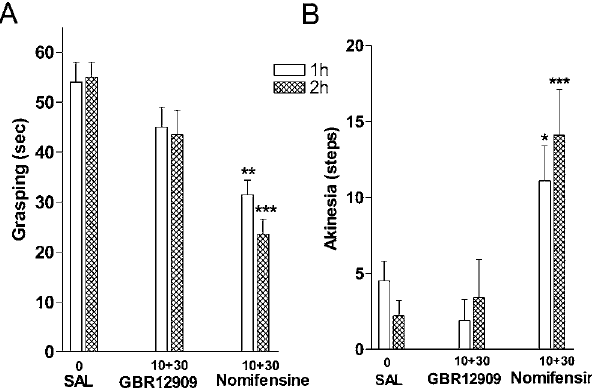
Figure 7. Nomifensine, but Not GBR12909, Is Effective in Reversing Abnormal Motor Behaviors of DDD Mice DAT-KO mice were placed in the locomotor activity chamber and 30 min later were treated with a MT (250 mg/kg IP). Mice were challenged 1 h later with two doses (10 and 30 mg/kg IP) of each drug or saline with a 1 h interval between treatments ( n ¼ 9–15 per group). Grasping (A) and akinesia (B) tests were performed as described in Materials and Methods 1 h after each dose. A single asterisk indicates p , 0.05, double asterisks indicate p , 0.01, and triple asterisks indicate p , 0.001 versus respective values of saline-treated DDD mice (one-way ANOVA followed by Dunnet’s multiple comparison test). Note that no significant differences between GBR12909-treated mice and saline-treated controls in both tests were found, whereas nomifensine-treated mice were significantly different from GBR12909-treated mice ( p , 0.05) in both experimental paradigms and doses tested. DOI: